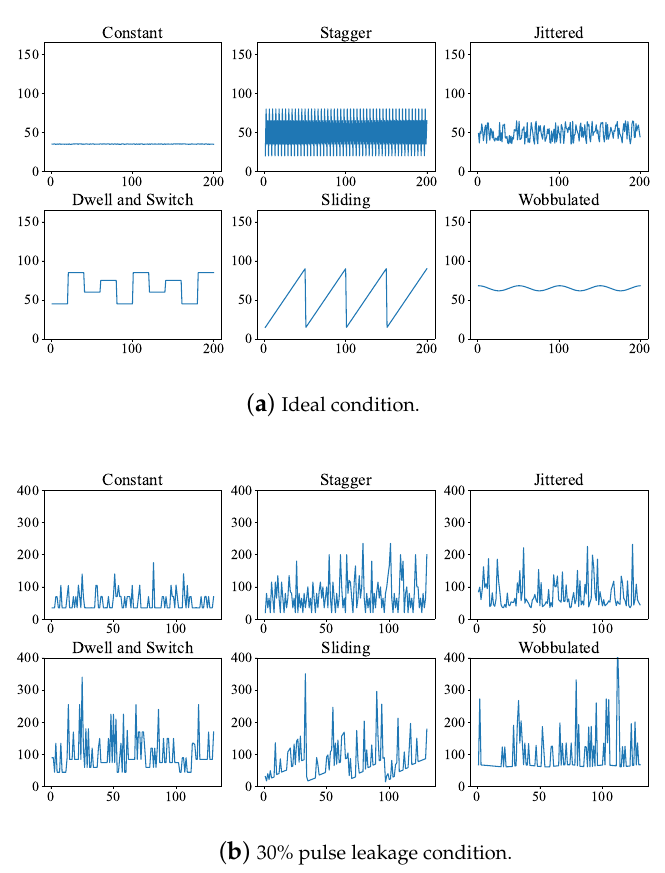
Figure 2. Conventional modulation styles in different environments. ( a , b ) respectively show 6 modulation styles under ideal conditions and 30% lost pulse